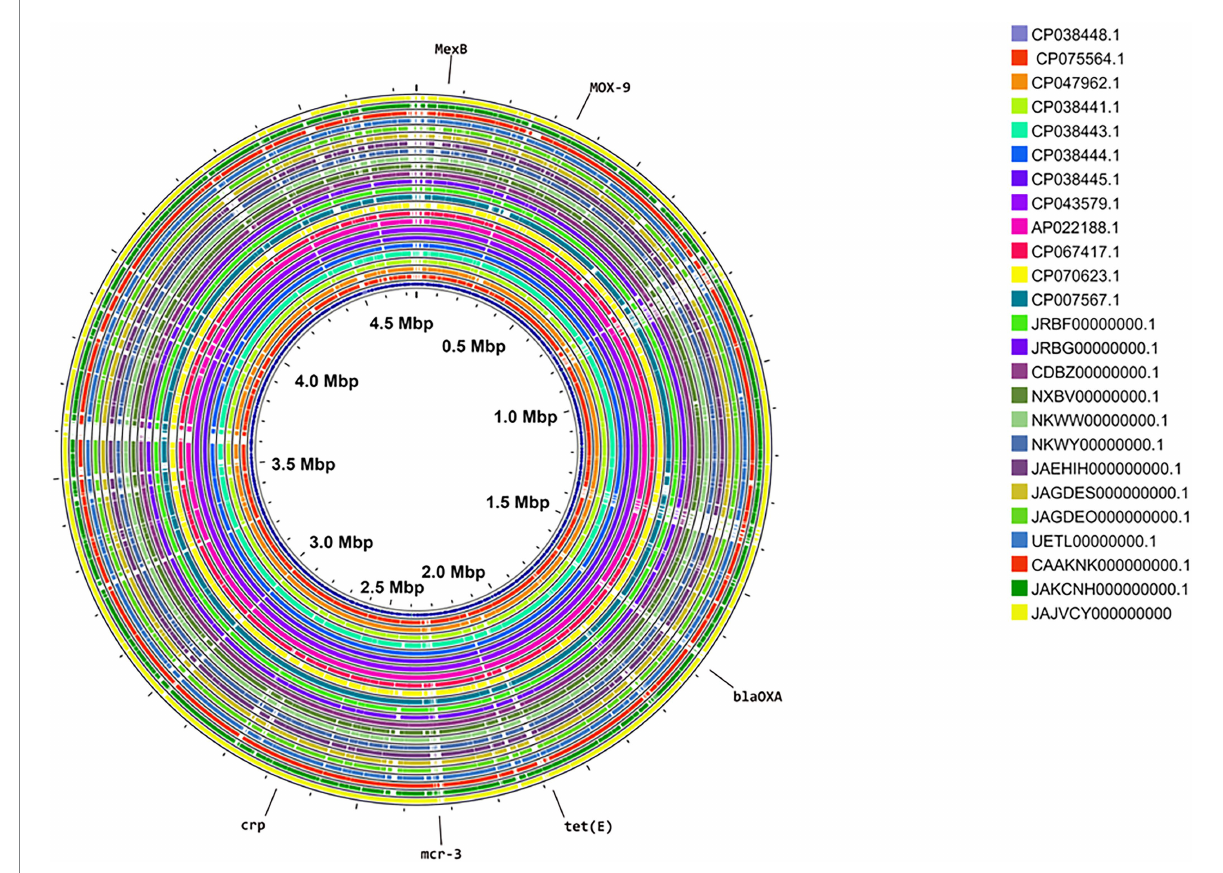
FIGURE 1 Circular map showing a comparison of the genome of Aeromonas media strain SD/21–15 together with genomes retrieved from the National Center for Biotechnology Information (NCBI) public databank obtained from different host species and environmental samples from different geographical areas in the world (See Table 1). Note strain SD/21–15 (JAJVCY000000000; outermost) shows a complete circular map similar with other 25 A . media strains. Figure 1 was created in Proksee